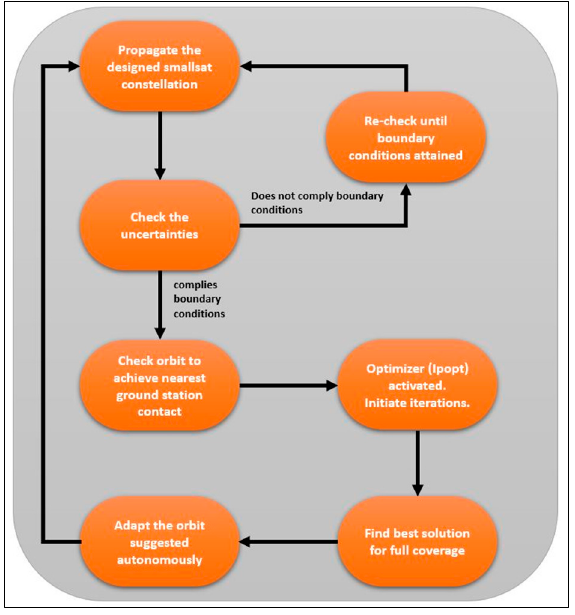
Figure 14. Proposed propagation technique for autonomous optimization.